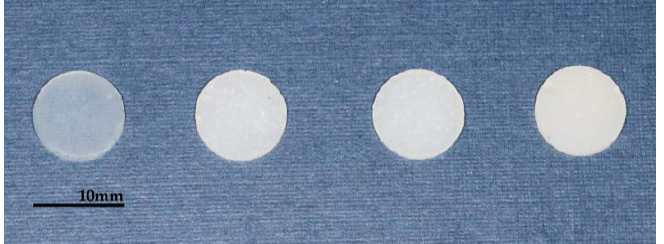
Figure 1. Resin Discs (SAR, SAR + 1% MBN, SAR + 3% MBN, SAR + 5% MBN, scale bar: 10 mm). Table 1. Composition of ortho connect flow.